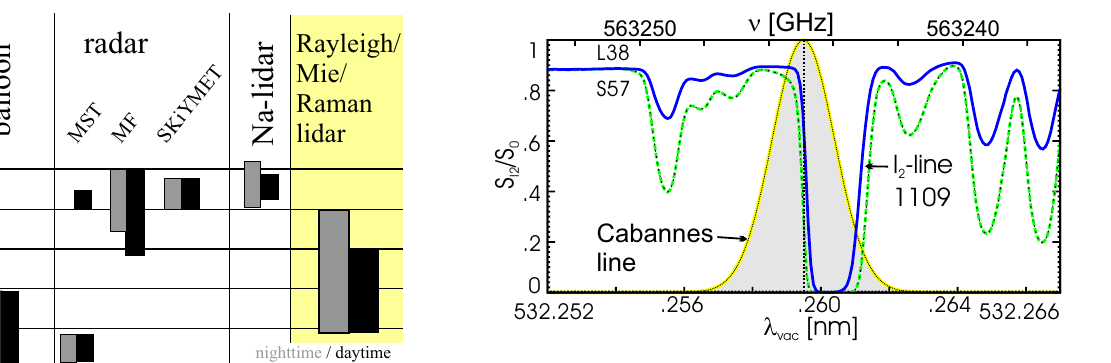
Fig. 2. Measured transmission spectrum of iodine for two cells of different length at different temperatures: 38 ◦ C (blue L38:15cm long), 57 ◦ C (green S57:10cm long). For reference, the Doppler broadened Cabannes line for 230K is shown. The wavelength of the seed laser is indicated by a dotted vertical